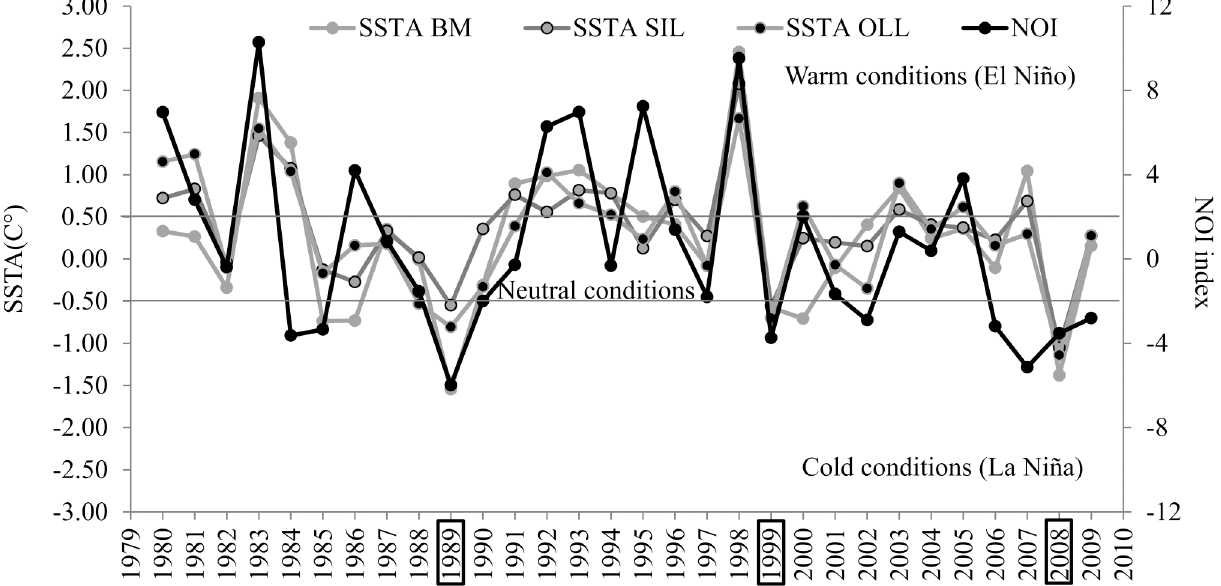
Fig 8. Climate variability at coastal areas in front of the breeding lagoons. mean (January-February) SST anomalies (SSTA) for Bahia Magdalena (BM), San Ignacio Lagoon (SIL) and Ojo de liebre Lagoon (OLL), and the ENSO index (NOI); the NOI index was multiplied by-1 for purposes of illustration; boxed years are reports of gray whale sightings in atypical southern locations [5, 26,